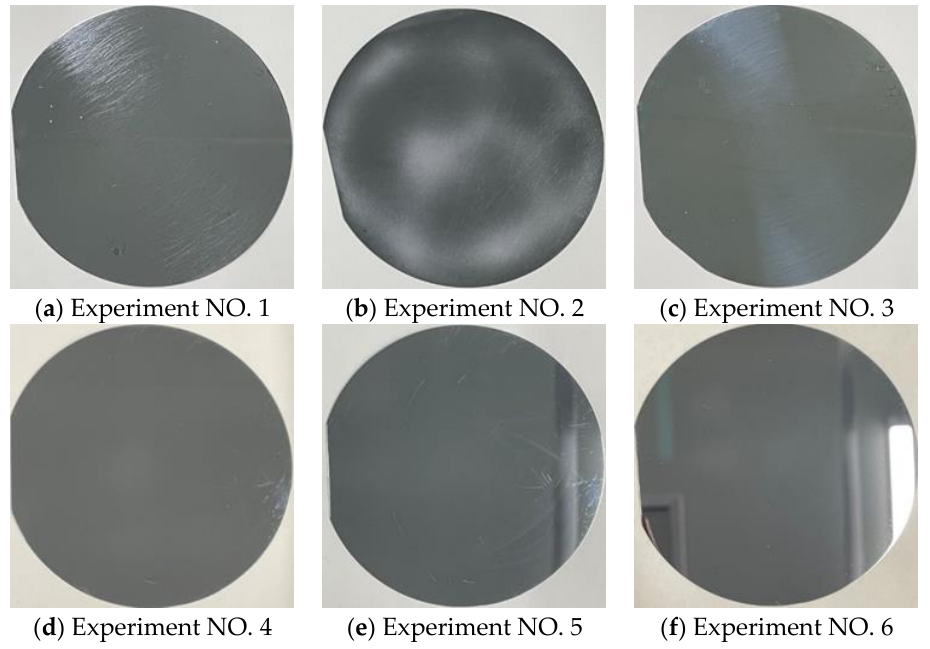
Figure 34. Workpiece surface morphology. The scratches on the surface of each workpiece were measured using a white light interferometer (Zegage Plus, Zygo Inc., Middlefield, CT, USA), as shown in Figure 33b. The shape and number of scratches can be clearly observed in Figure 35. In figure (a), the number of long scratches in the range of 900*900 μm is 13, and all of them are deep scratches. In figure (b), the number of scratches is 4, and all of them are deep scratches, and the surface roughness is large and there are many pits. In figure (c), the number of long scratches is 15, and the number of deep scratches is 3. In figure (d), the number of long scratches is 7, and the number of deep scratches is 1. In figure (e), there are two scratches, and one of them is deep, and in figure (f), there is one scratch, but the depth of the scratch is shallow. The results verified the accuracy of the simulation results and the feasibility of the combination of parameters that could minimize the scratch damage.